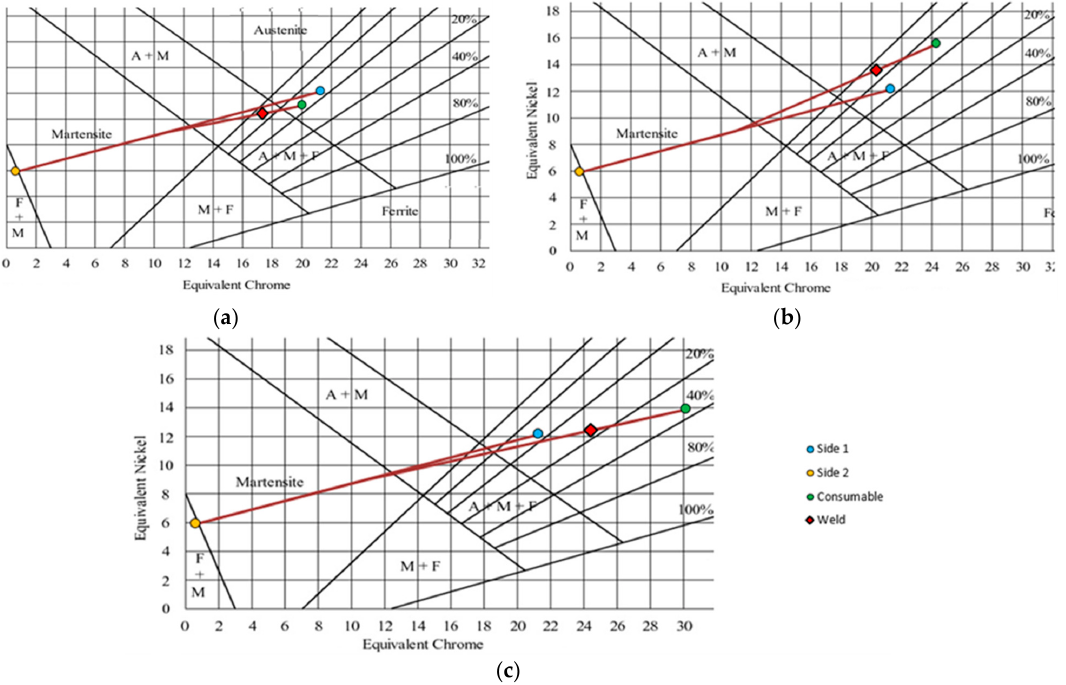
Figure 8. Predicted fusion zone microstructure of dissimilar carbon steel and SS316 weld using a Schaeffler diagram in ( a ) E308 welding electrode, ( b ) E309 welding electrode, ( c ) E312 welding elec- trode.